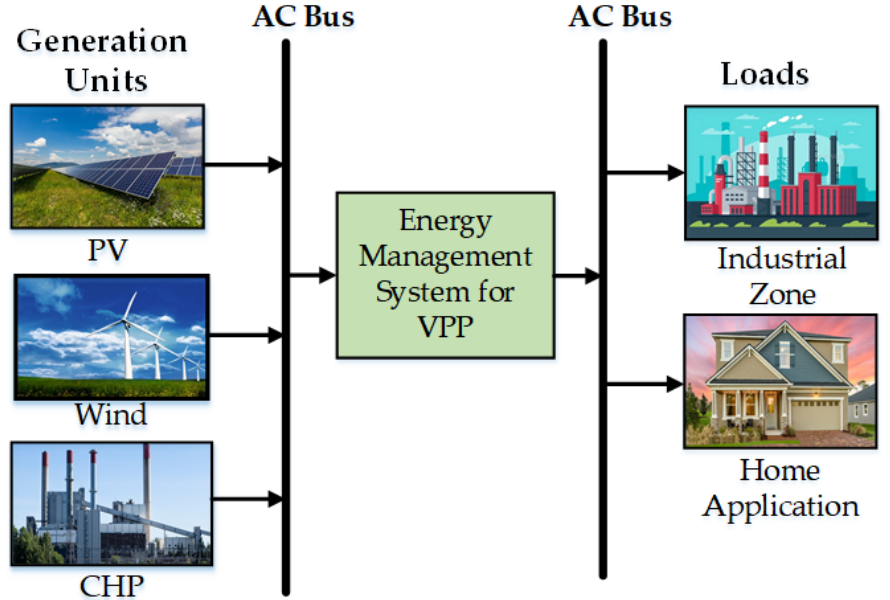
Figure 3. An overview of VPP consists of several generations and distribution units and is managed by an appropriate energy management system (Note: AC-alternating current; DC-direct current; PV-photovoltaics; VPP-virtual power plants; CHP-combined heat and power).